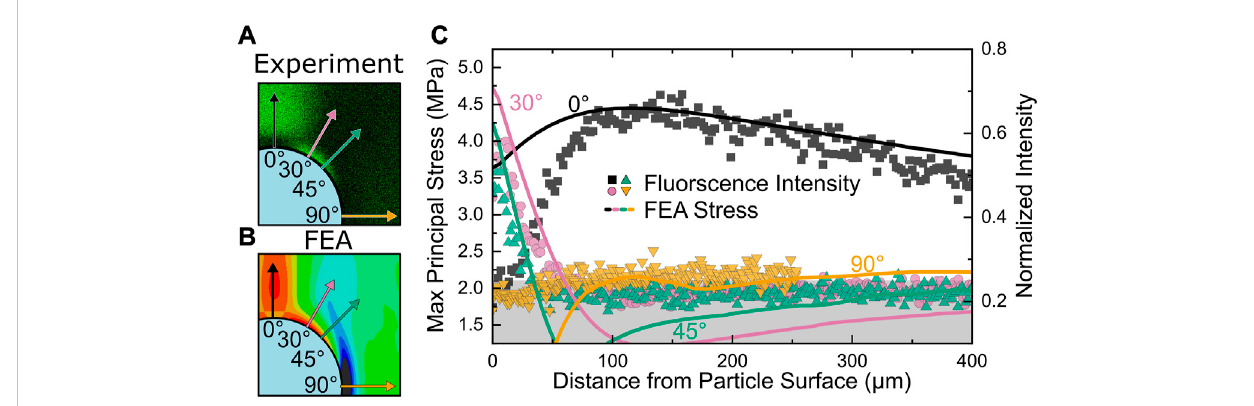
FIGURE 3 Fluorescence intensity and stress distributions as a function of angle. (A) Fluorescence and (B) FEA images illustrating locations of line scans taken fromtheedgeoftheparticleandextendingradiallyoutwardintothematrixat0 ° ,30 ° ,45 ° ,and90 ° relativetotheloadingdirectiontoquantifyintensityand stress, respectively. Images are 500 μ m by 500 μ m. (C) Normalized fl uorescence intensity and maximum principal stress as a function of distance from particle surface.The region ingrey indicates theregion where thebackground fl uorescence intensitydominates theresponse. This region doesnot